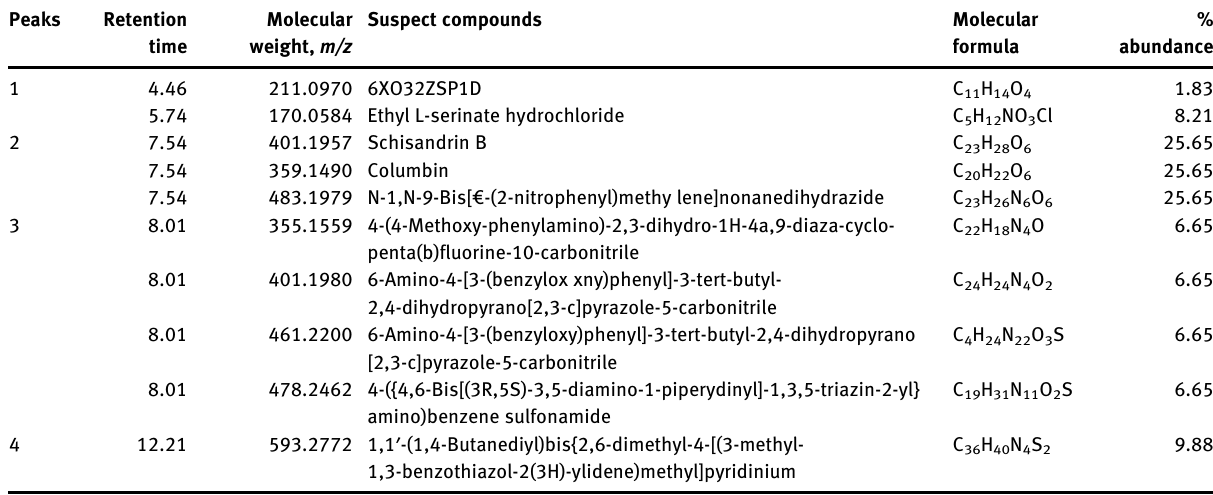
Table  : Bioactive compounds of ethyl acetate fraction by LC-MS analysis.